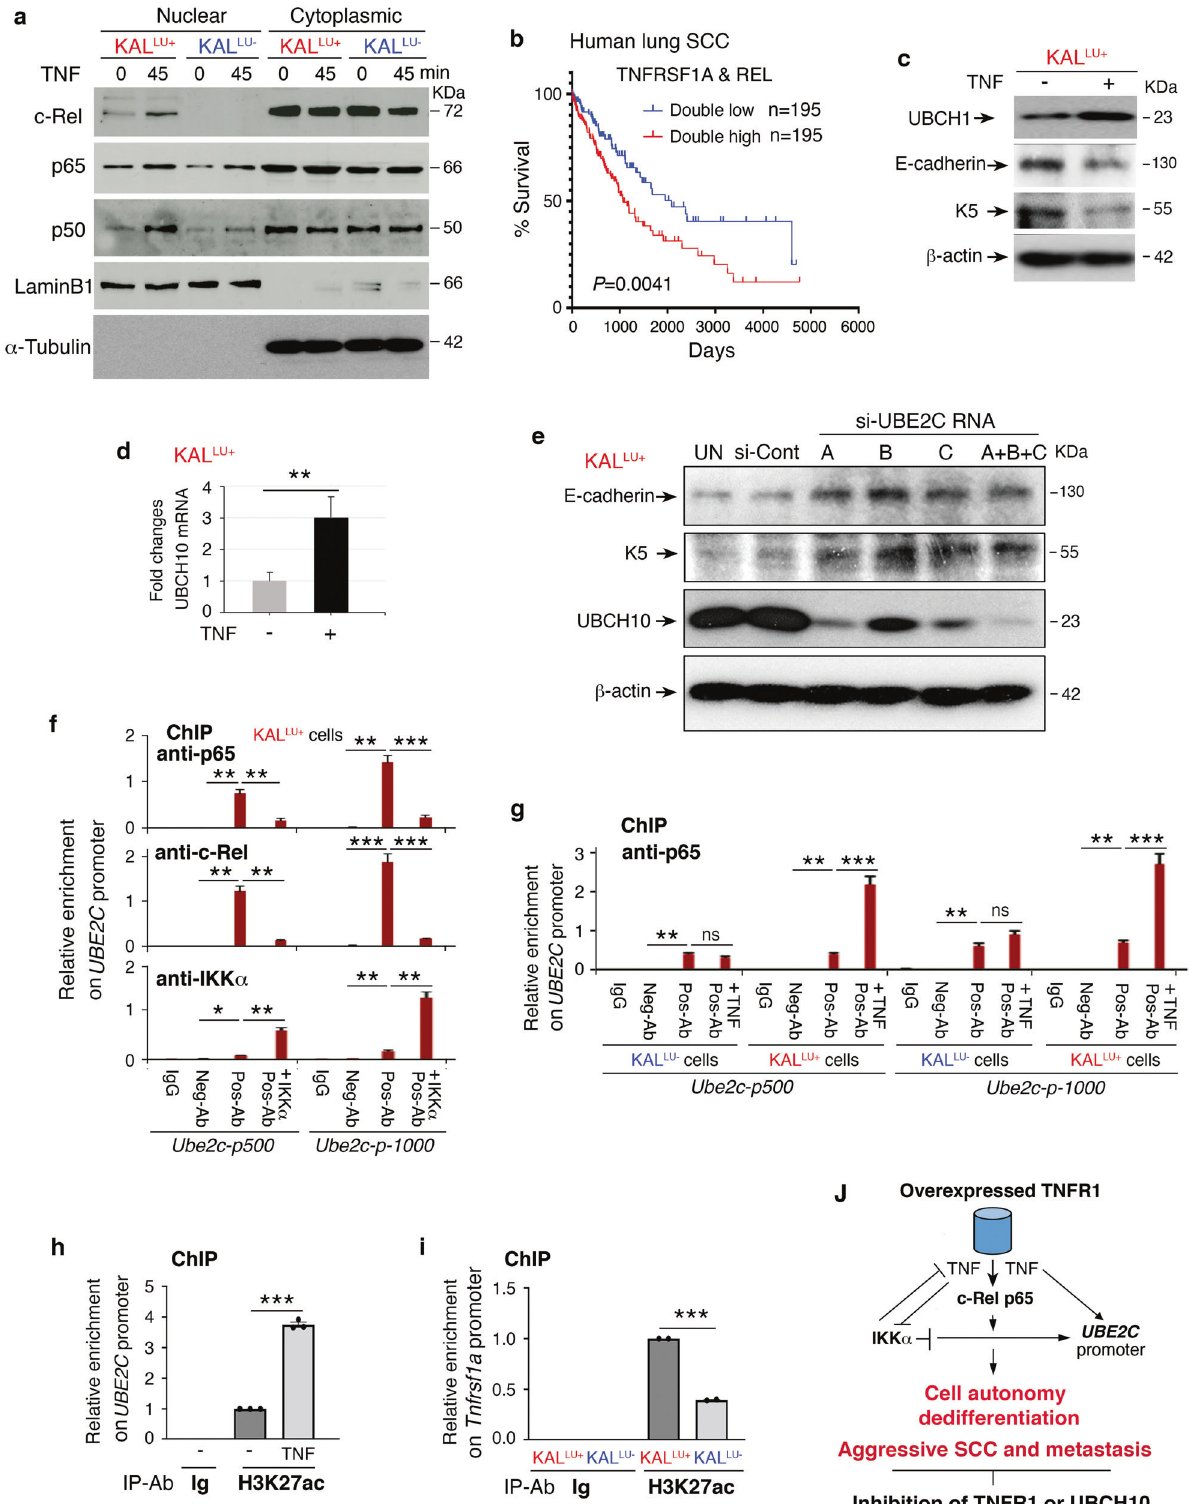
Cell proliferation assay Mouse lung tumor cells (1 × 10 5 /per well) were seeded into 6 well-plates in DMEM with 5% bovine calf serum. The numbers of the treated cells were counted 2 days after the cells were transfected with a control vector or HA- IKK α plasmid. Data represent the mean ± S.D. of three independent experiments. For the MTT assay to examine cell proliferation, the cells were